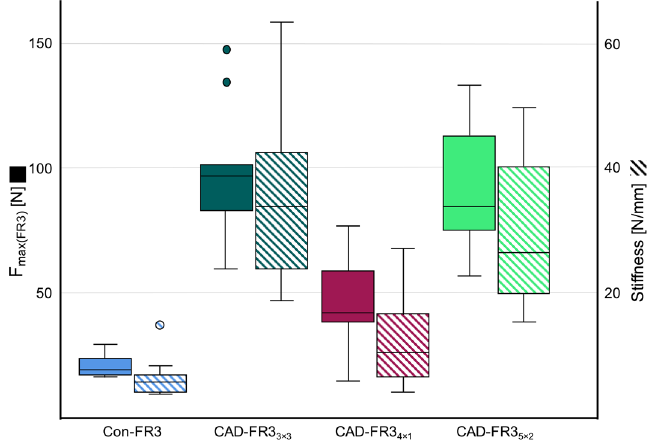
Figure 7. Results of transversal testing. All CAD/CAM function regulator 3 (CAD-FR3) groups had a higher mean load capacity (F max(FR3) ) than the conventional FR3 group (Con-FR3). The mean F max(FR3) of CAD-FR3 3×3 and CAD-FR3 5×2 were nearly five times higher than that of Con-FR3. CAD-FR3 4×1 had the lowest mean F max(FR3) of all CAD-FR3 designs, and two individual cases even had the lowest F max(FR3) of all FR3s tested. All CAD-FR3 groups had higher mean stiffness than the Con-FR3 group. Load application above F max(FR3) caused most CAD- FR3s to break, whereas in all the Con-FR3s this resulted in plastic